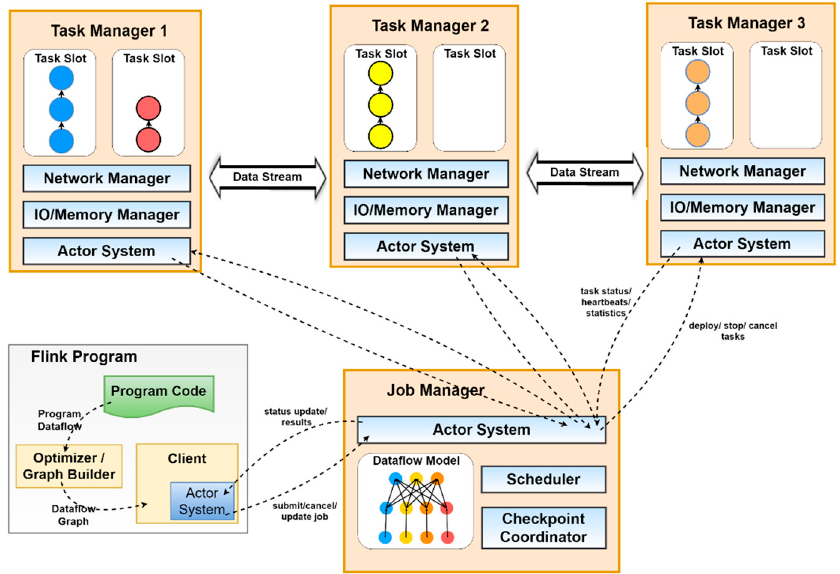
Figure 2. Apache Flink architecture: Running and dataflow creation of a Flink program on the Flink system, and distribution of the operators to the available slots on each Task Tracker by the Job Manager through the Actor system.